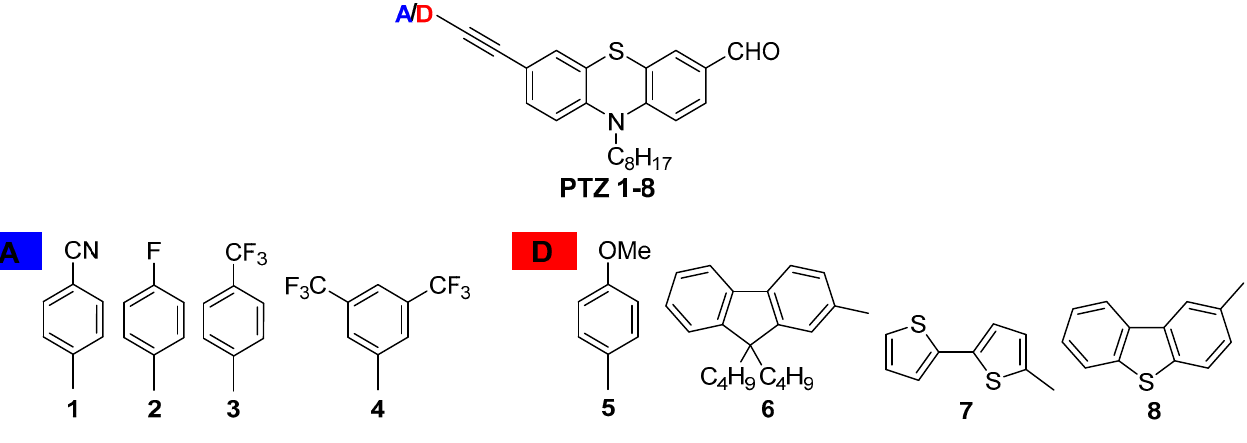
Figure 9. Structures of phenothiazine derivatives PTZ 1 – 8 .